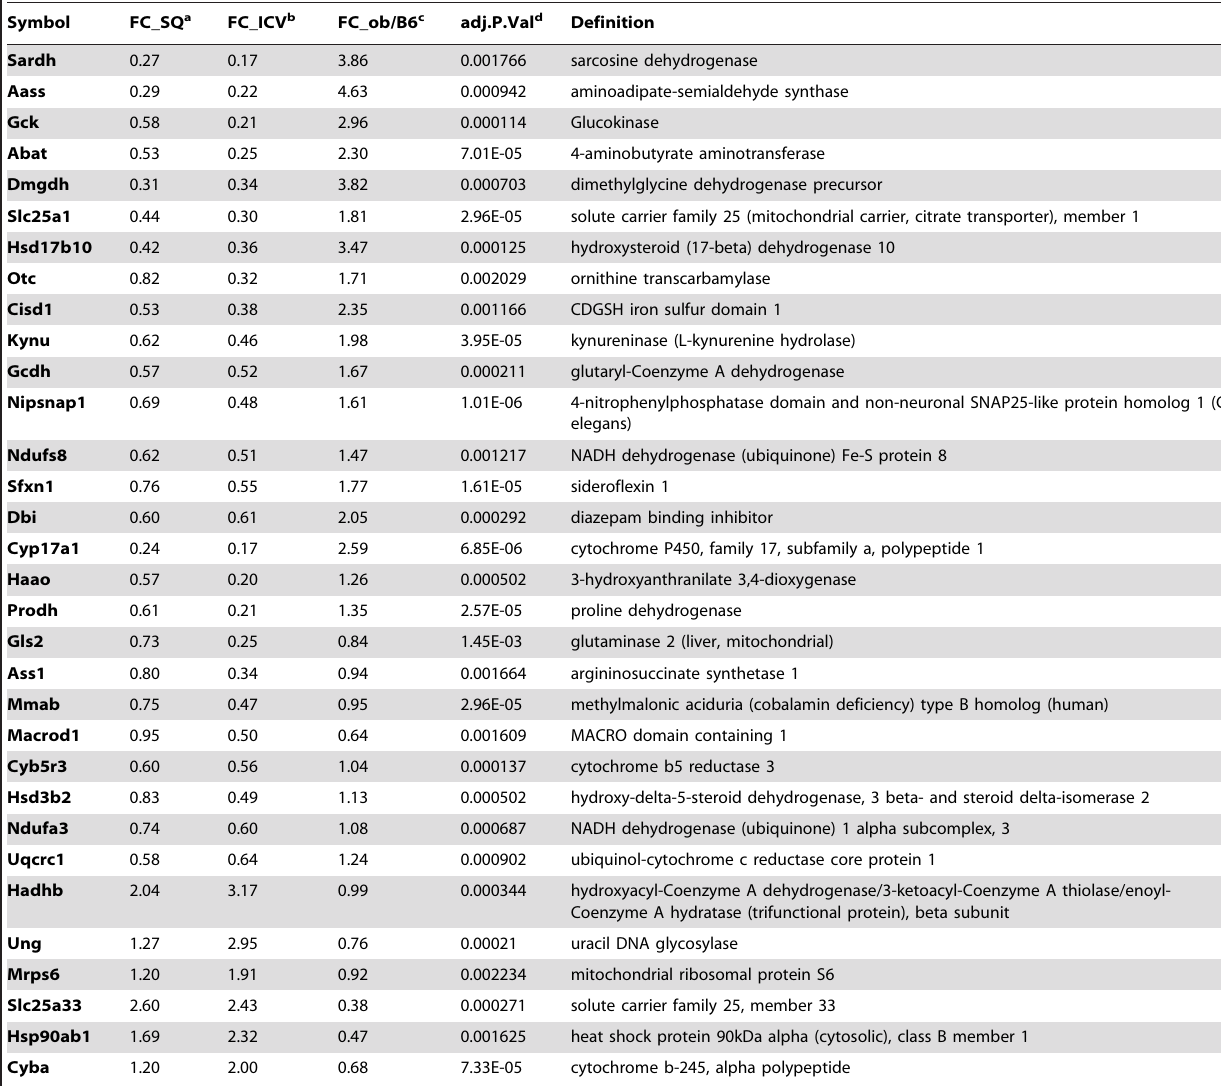
Table 3. 32 mitochondrial genes involved in leptin